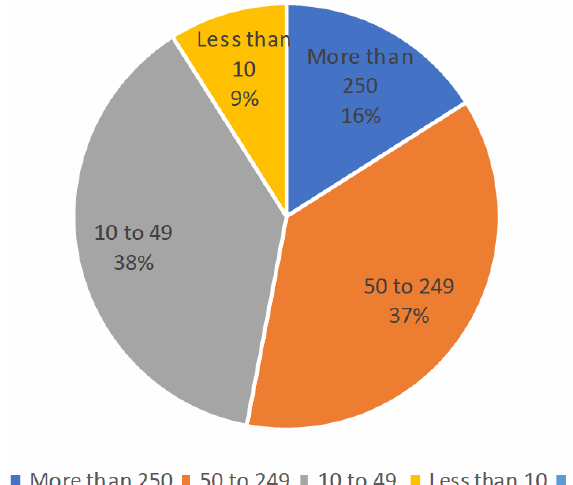
Figure 2. Sample characterization Three components of ISO 9001 certification explain 87.087% of the total